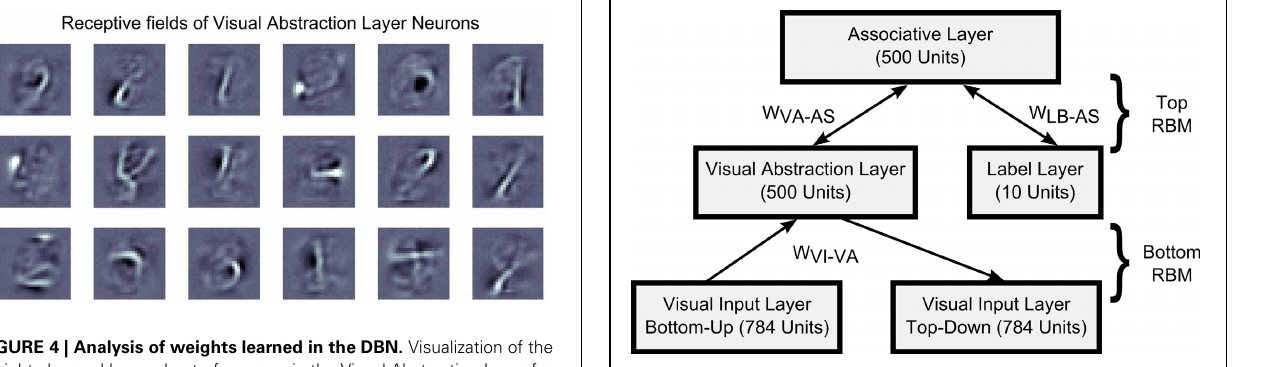
FIGURE 5 | DBN architecture for recognition and generation. The Visual Input Layer was split into a bottom-up and a top-down part, used for projecting inputs in Recognition mode, or visualizing top-down activity in Generation